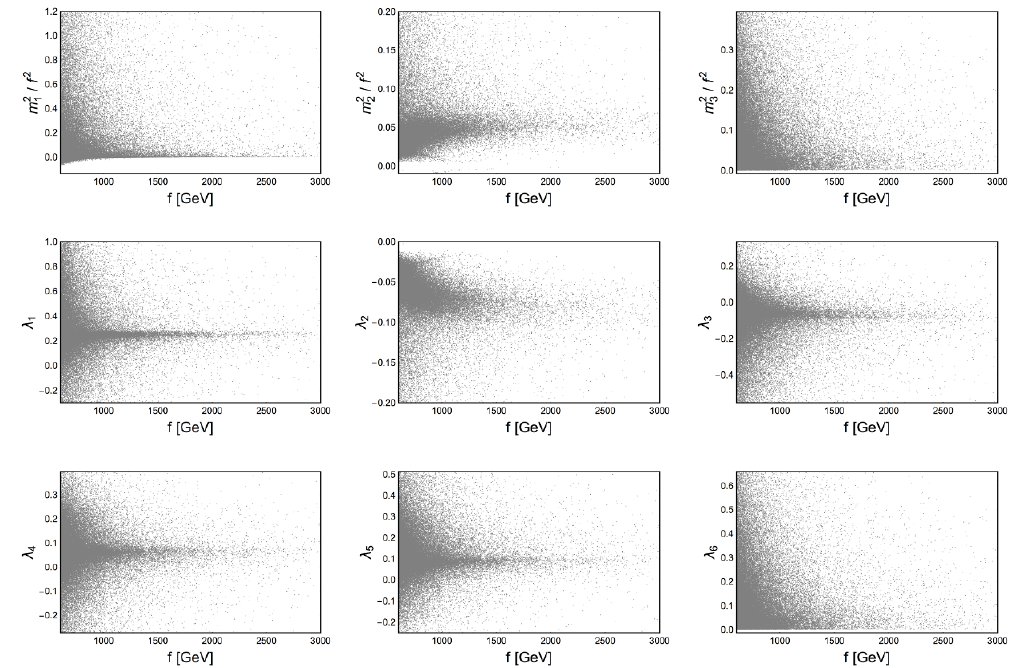
Figure 3 . The mass parameters and the quartic couplings of the scalar potential as functions of f . Notice that (cid:21) 6 = (cid:21) 7 .